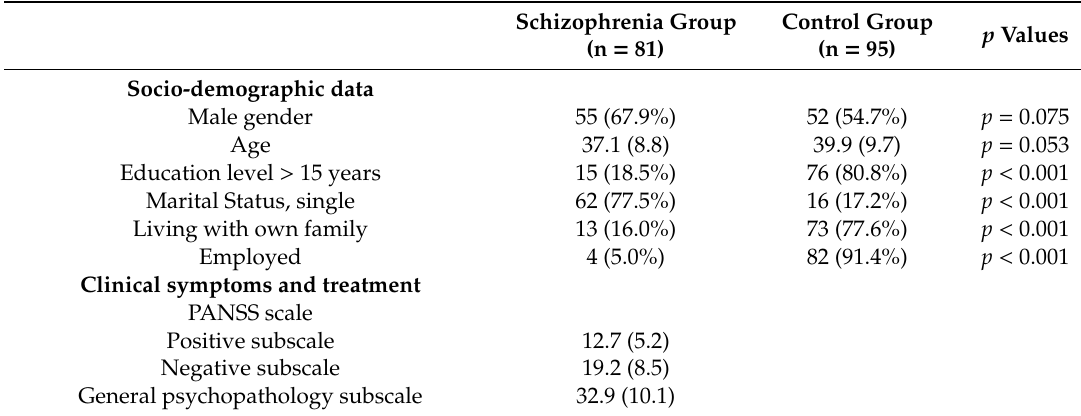
Table 1. Socio-demographic, clinical data, religiousness, and interpersonal reactivity (IRI) profiles of the